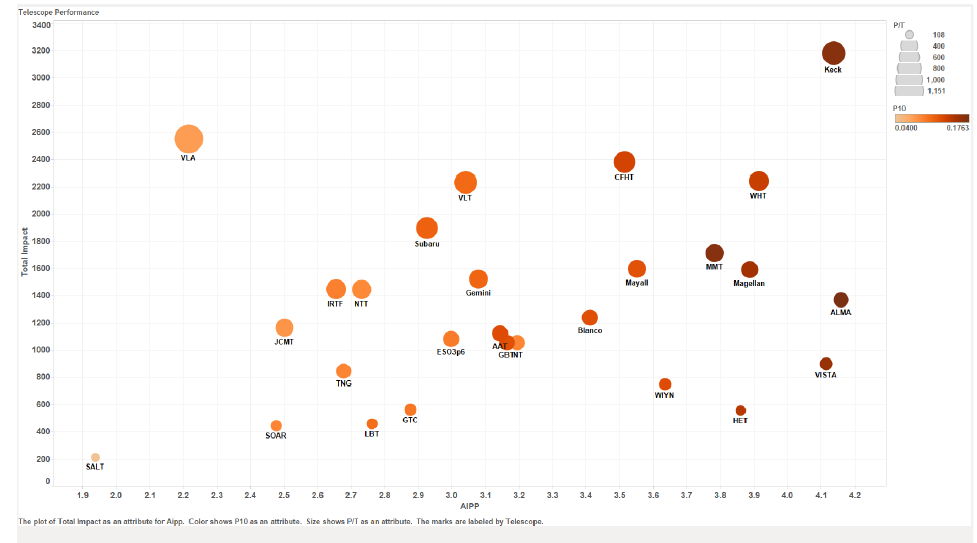
Figure 5. Performance plot of all